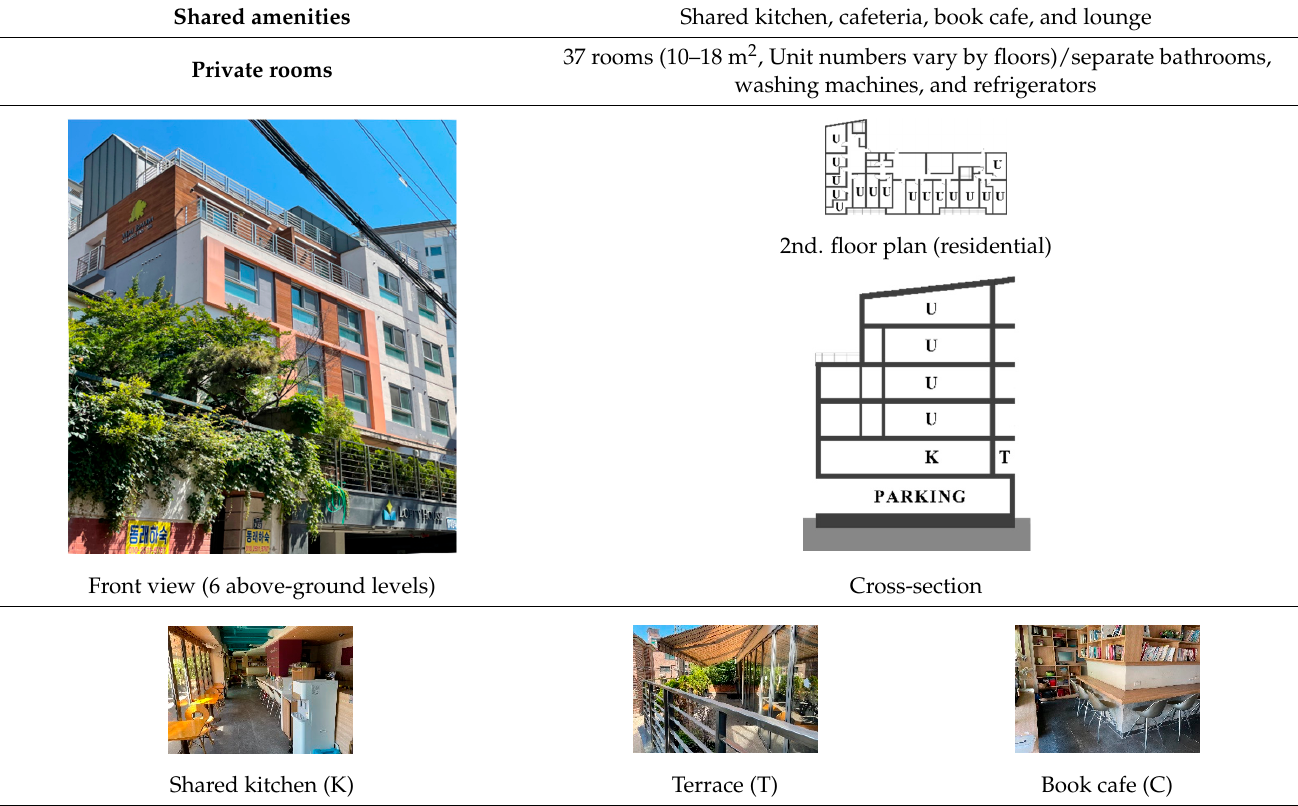
Table 3. Lofty house [20].